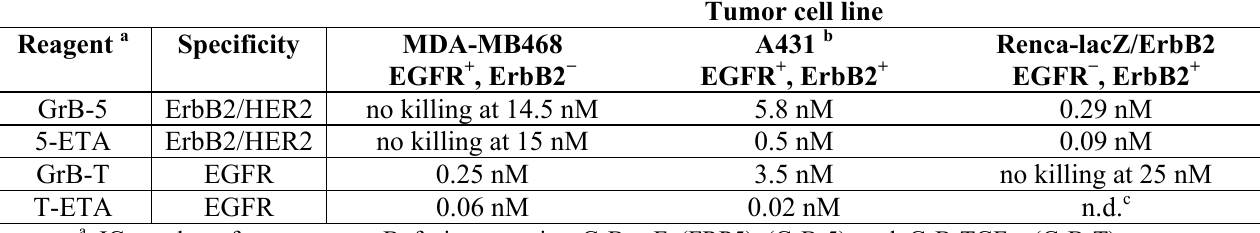
Tumor cell line